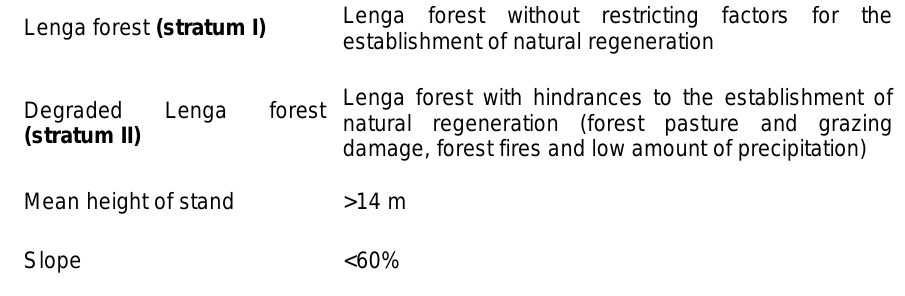
Criteria for Distinguishing Lenga Forest Types